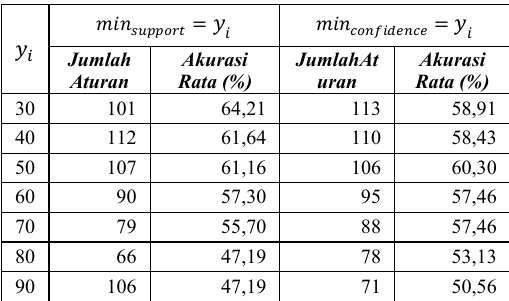
Aturan Asosiasi dengan Standar STORET pada Model Prediksi Parameter Pendukung Uji Kualitas